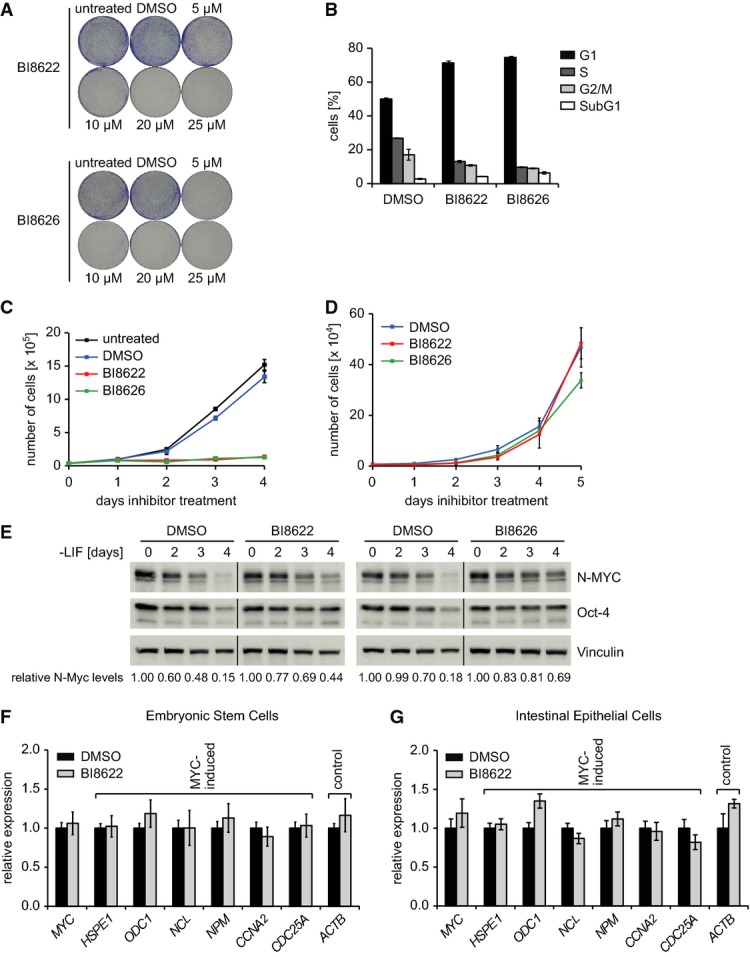
Effect of HUWE1 inhibition on growth and gene expression in epithelial and embryonic stem
cellsColony formation assays documenting growth of Ls174T cells in the presence of the indicated
concentrations of HUWE1 inhibitors. Cells were stained after 5 days.Cell cycle distribution of Ls174T cells upon HUWE1 inhibition. Inhibitors or DMSO as control were
added to Ls174T cells for 24 h. Before harvesting, cells were labeled for 1 h with
BrdU. Error bars represent SD of technical triplicates from one representative experiment
(n = 2).Growth curve of Ls174T cells cultivated in the presence of HUWE1 inhibitors. Untreated or
DMSO-treated samples served as control.Proliferation of HUWE1 inhibitor-treated murine embryonic stem (ES) cells. ES cells were
cultivated in the presence of leukemia inhibitory factor (LIF) and HUWE1 inhibitors
(10 μM) or DMSO as control. Data show mean cell number ± SD
(n = 3).ES cells were deprived of LIF for the indicated times and in parallel treated with HUWE1
inhibitors or DMSO as control. The panel shows immunoblots documenting N-MYC, Oct-4, and Vinculin
protein levels. A quantitation of N-MYC protein levels relative to Vinculin is shown below the blot
(n = 3).RQ–PCR assays documenting expression of MYC target gene expression in murine ES cells (F)
and in crypt cultures of normal intestinal epithelial cells (G) upon inhibition of HUWE1. ES cells
were cultivated in the presence of LIF and treated with BI8622 (10 μM) for 48 h
(left panel). Intestinal organoid cultures were treated with BI8622 (10 μM) for
24 h (right panel). DMSO served as solvent control. Error bars show SD of technical
triplicate assays of one representative experiment (F: n = 2;
G: n = 3).